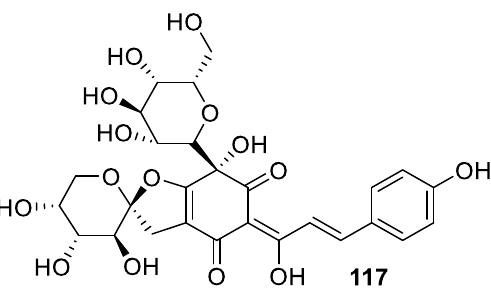
Figure 54. [4.5.0] spirocyclic quinochalcone saffloquinoside A isolated from Carthamus tinctorius.